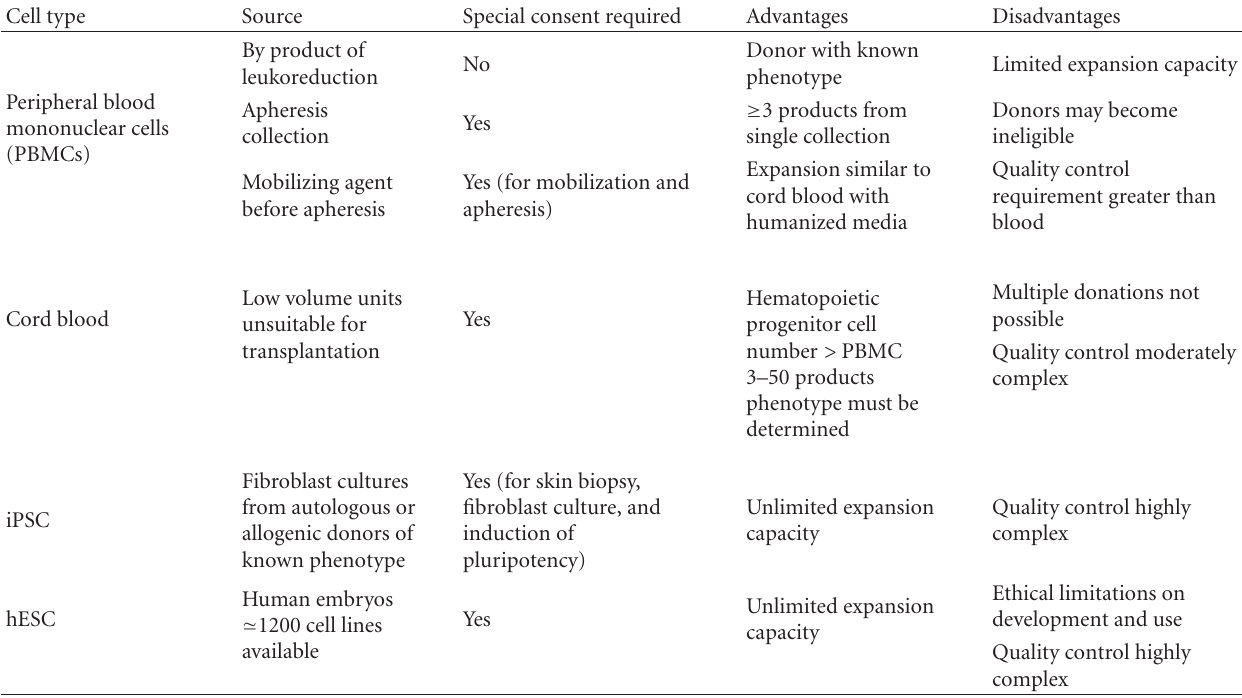
Table 1: Cell sources for ex vivo generation of red blood cells ∗